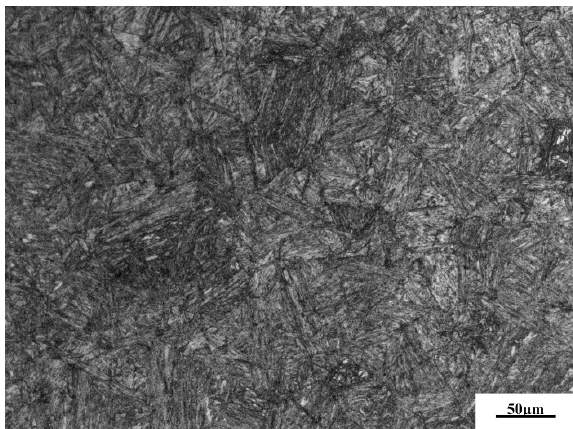
Figure 1. Microstructure of the KMN-I base metal.